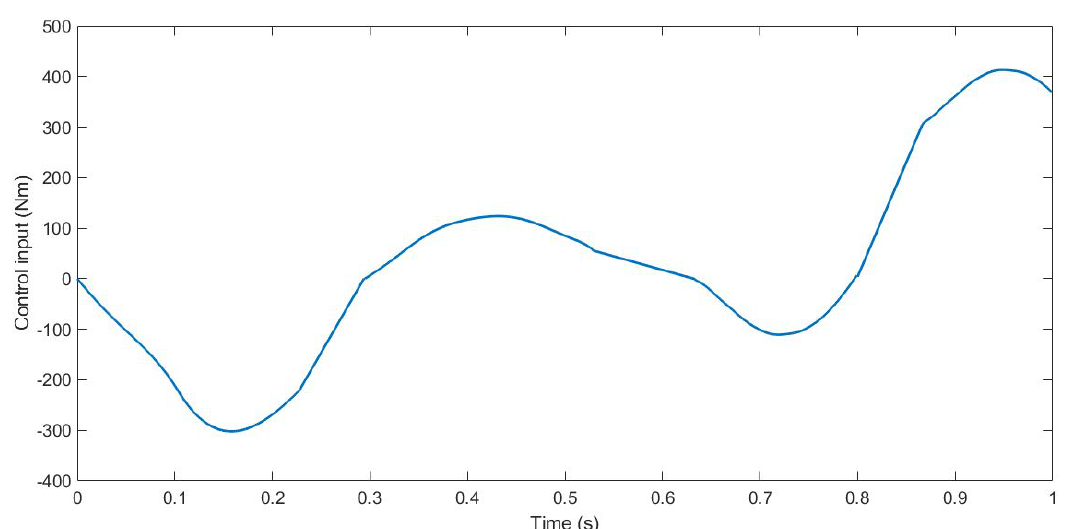
Figure 7. Control input u for Test